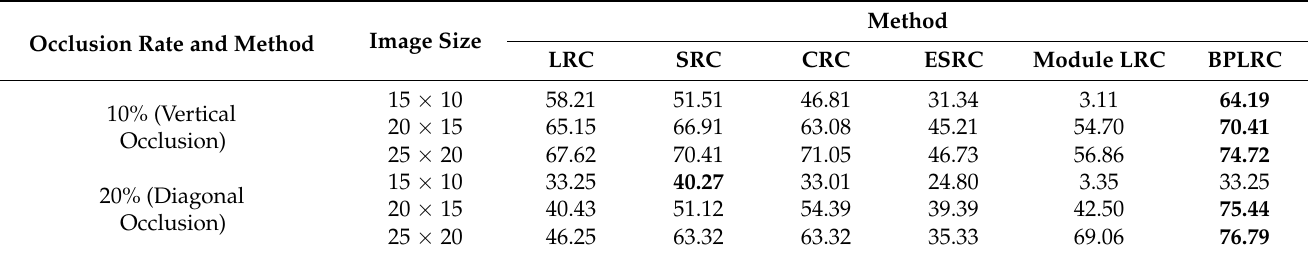
Table 5. Accuracy (%) of different methods when identifying 10% vertically and 20% diagonally occluded face images in the Extended Yale B database.